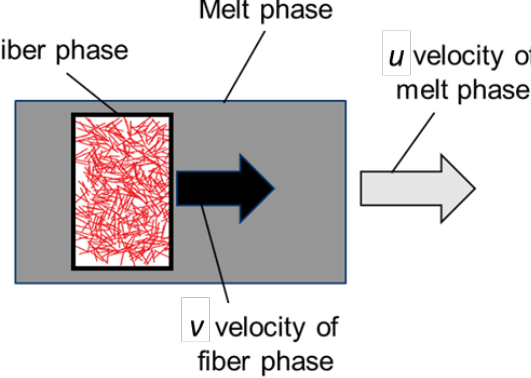
Figure 5. Two-phase model for relative motion between fiber and polymer melt phase.